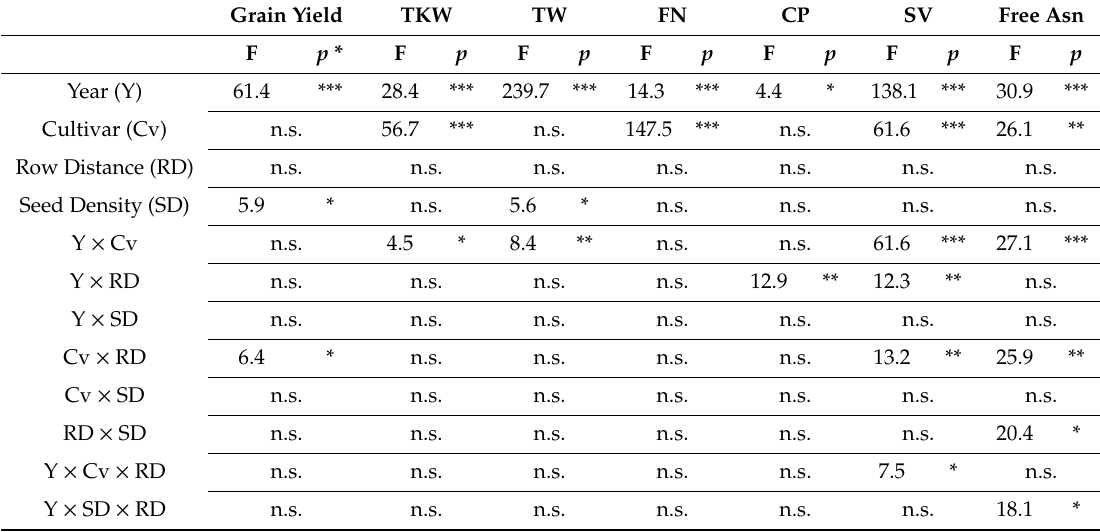
Table 3. F-values and p -values for all main e ff ects and interactions, where at least one tested trait had a significant impact on grain yield [kg ha − 1 ], thousand kernel weight (TKW) and quality parameters: Test weight (TW), falling number (FN), crude protein (CP), sedimentation value (SV), and free Asn of